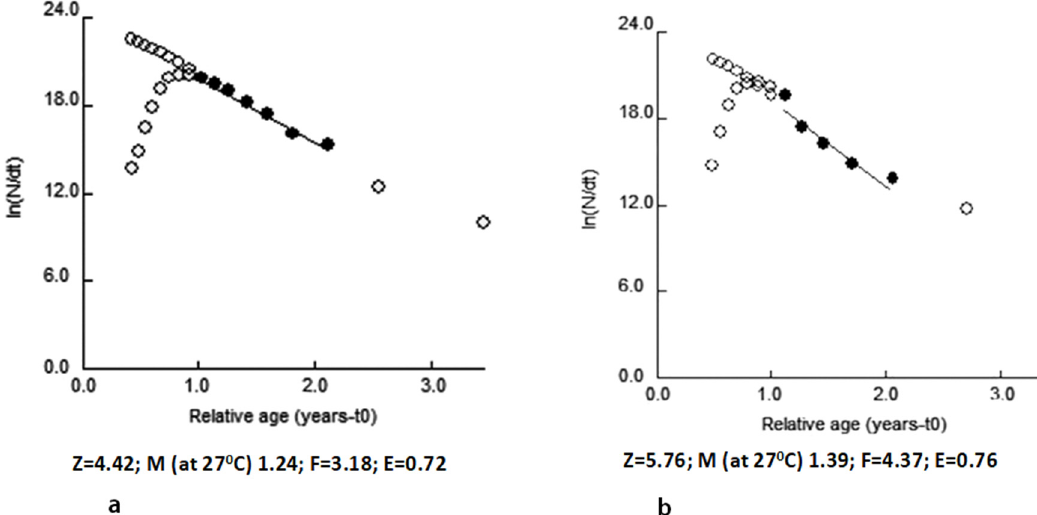
Fig. 6. Mortality in (a) female, and (b) male P. stylifera.